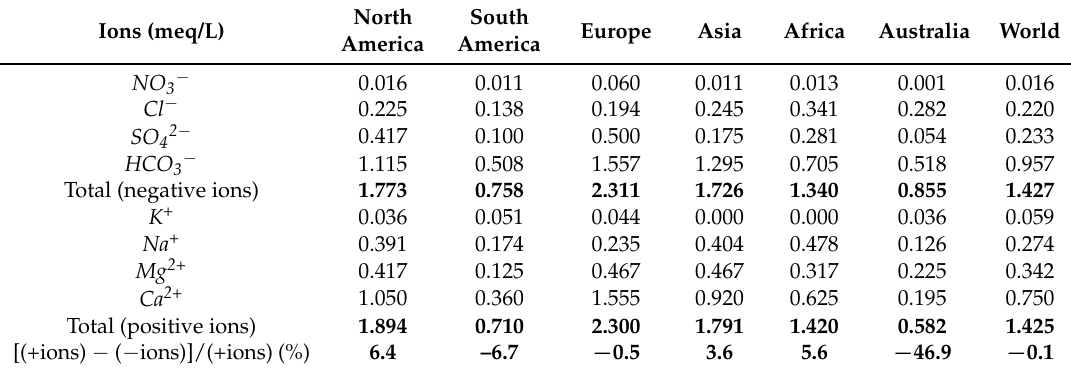
Table 4. Charge balance of the concentrations of MI per continent, based on Table 1.